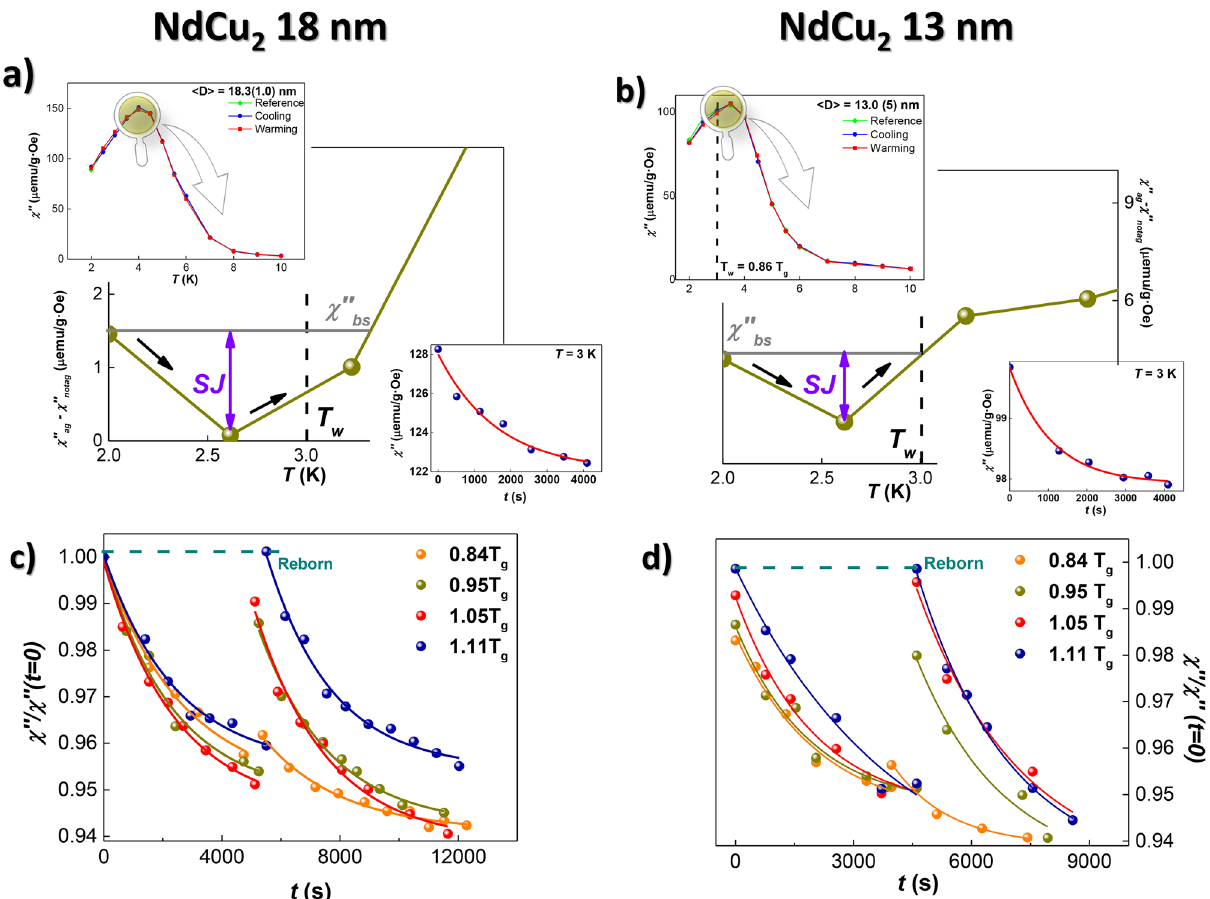
Figure 2. AC susceptibility results. Memory effects and aging phenomena measured at f = 0.2 Hz and µ 0 h ac = 0.313 mT for 18 nm-sized ( a , c ) and 13 nm-sized ( b , d ) NdCu 2 MNPs. In ( a , b ), the drop in − χ ′′ χ ′′ T (cid:31) T w (marked SJ in purple) evidences memory effects. Bottom insets in both figures depict the notag at ag relaxation behavior of χ ′′ ( t ) at T w . Note that the Y-axis are expressed in µ emu/gOe. ( c , d ) depict χ ′′ ( t ) measured at T w before and after applying 4 (cid:31) T (cycles). Note that the SG state is completely reborn for (cid:31) T = 1.11 T g